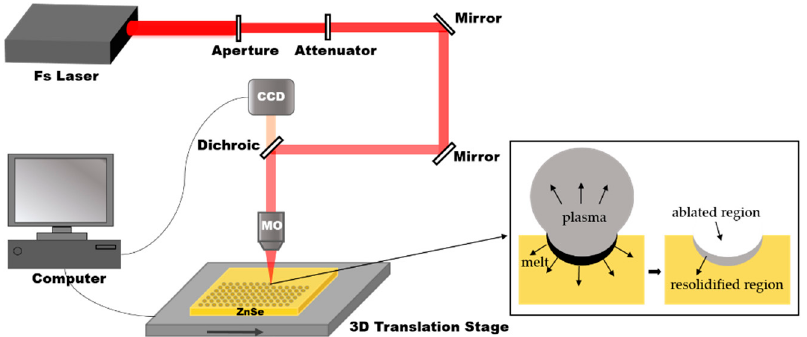
Figure 1. A schematic diagram of the fabrication process. The inset shows the formation mechanism of a microlens irradiated by a single femtosecond laser pulse, in which the Fs Laser is the femtosecond laser, CCD is imaging sensor, MO is the microscope objective. Scanning electron microscopy (SEM) images of the fabricated microlenses were ob- served using a Flex 1000 scanning electron microscope (Hitachi, Tokyo, Japan). A LEXT- OLS4000 laser confocal microscope (Olympus, Japan) (Olympus, Tokyo, Japan) was used to obtain the three-dimensional topography and the corresponding profile curves.